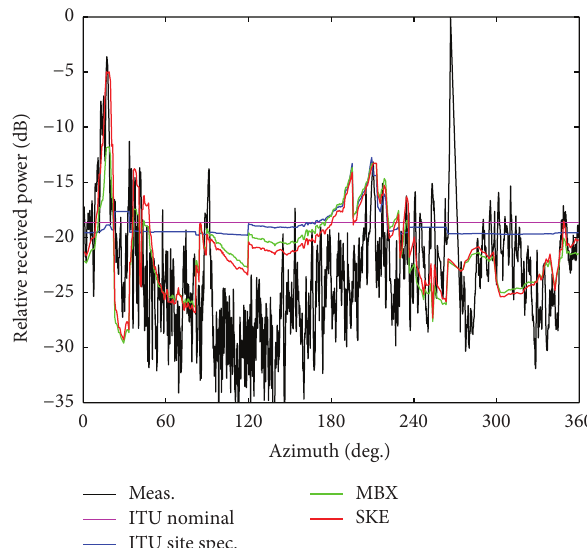
Figure 6: Scenario 2: a comparison of individual models: ITU-R P.452 nominal parameters (ITU nominal), ITU-R P.452 site-specific parameters (ITU site spec.), Maciel-Bertoni-Xia (MBX), Single knife-edge (SKE), and measured data (meas.).